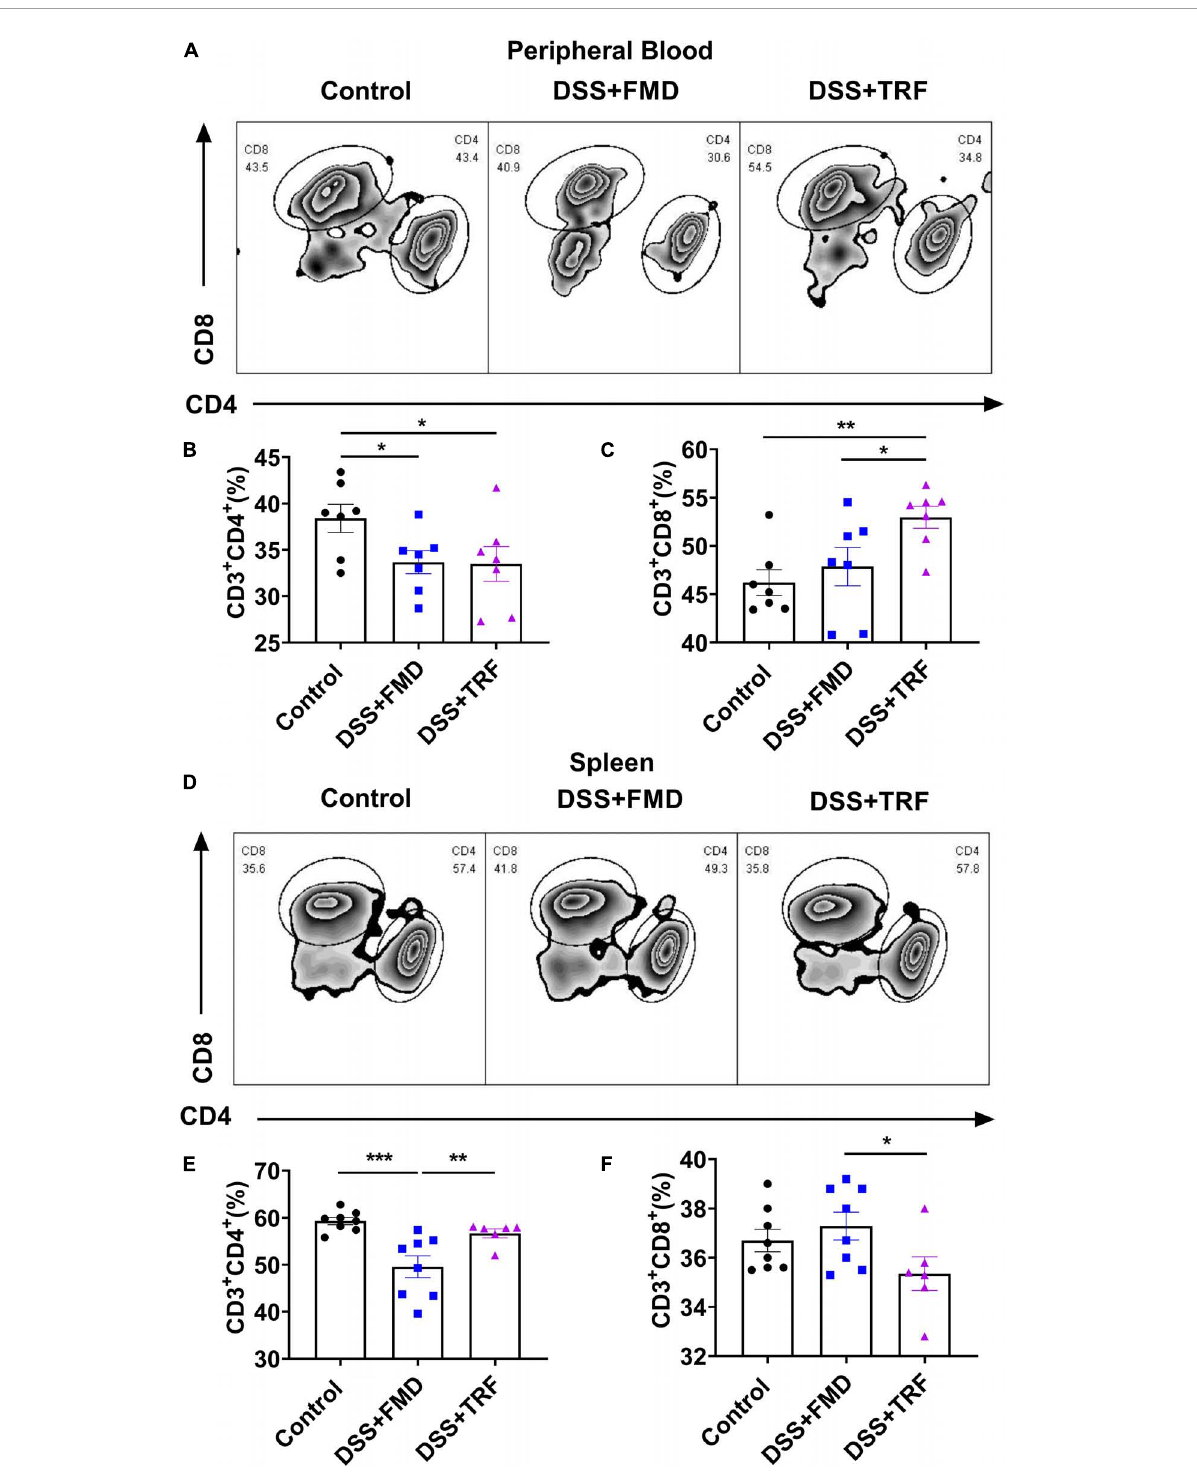
FIGURE3 TRF alters T cells profile in the peripheral blood and spleen. (A) Results of flow cytometry analysis to detect the proportion changes of CD4 + and CD8 + T cells in peripheral blood of mice at the end of experiment ( n = 7 for each group). (B) Percentage of CD4 + T cells in the peripheral blood. (C) Percentage of CD8 + T cells in the peripheral blood. (D) Results of flow cytometry analysis to detect the CD4 + and CD8 + T cells in the spleen at the end of experiment ( n = 6 to 8 for each group). (E) Percentage of CD4 + T cells in the spleen. (F) Percentage of CD8 + T cells in the spleen. Data are presented as mean ± SEM; * P < 0.05, ** P < 0.01, *** P <